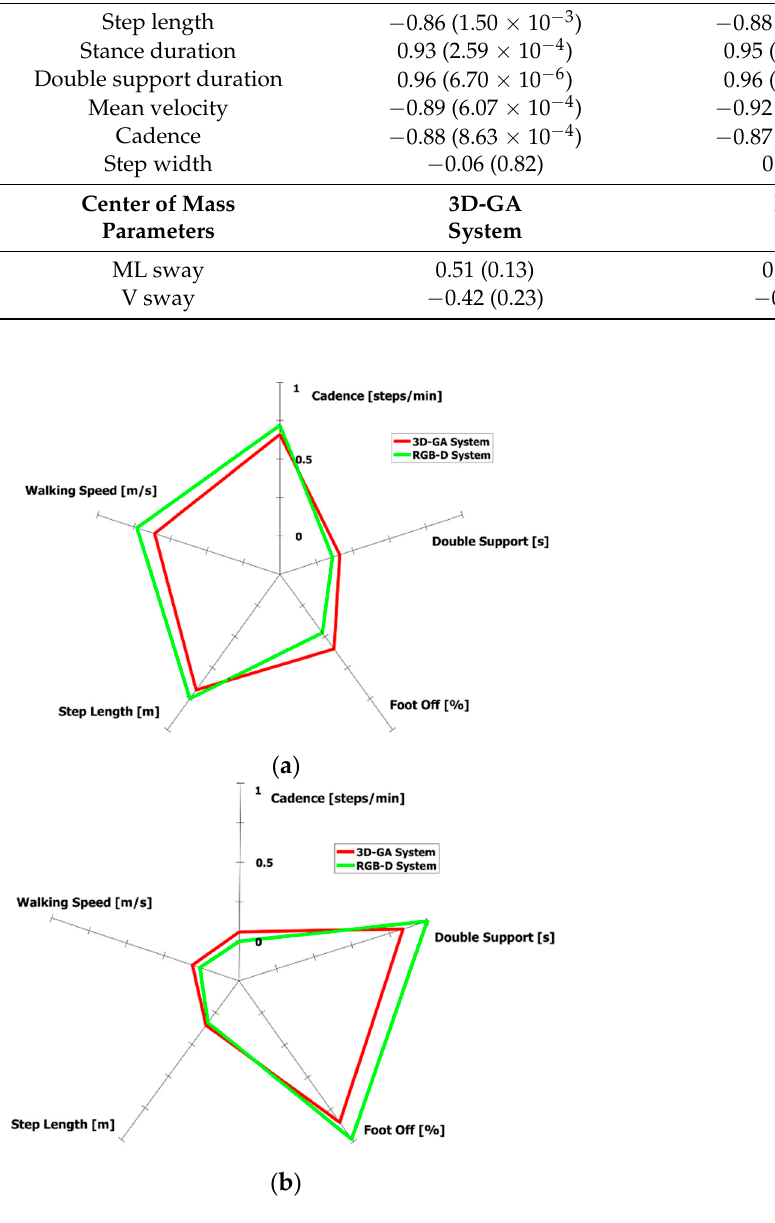
Figure 8. Example of radar charts on the estimated spatiotemporal parameters. ( a ) Radar chart related to good gait performance (Figure 7a). ( b ) Radar chart related to impaired performance (Figure 7b).